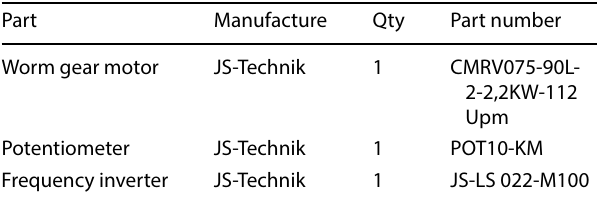
Table 3 Shredder components list Table 4 Time and mass of